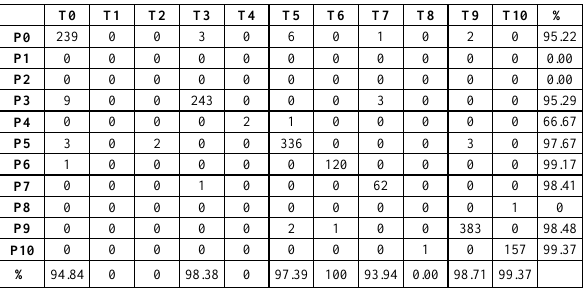
Table 5 Contingency Matrix for